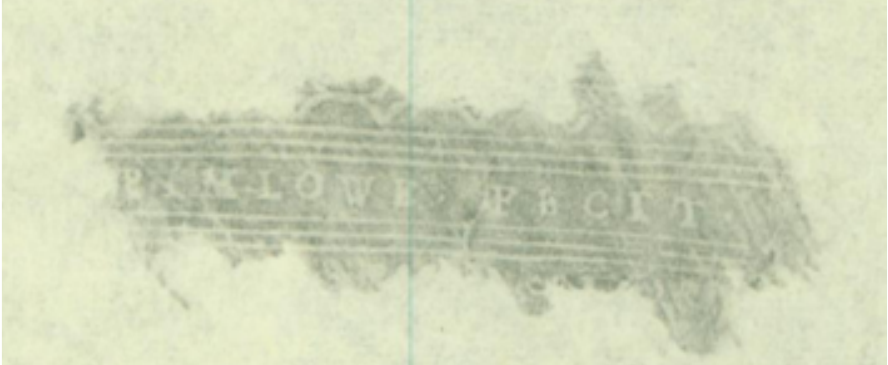
Fig 25c. Rubbing (enlarged) of signature PIMLOWE FECIT. Copyright © The British Library